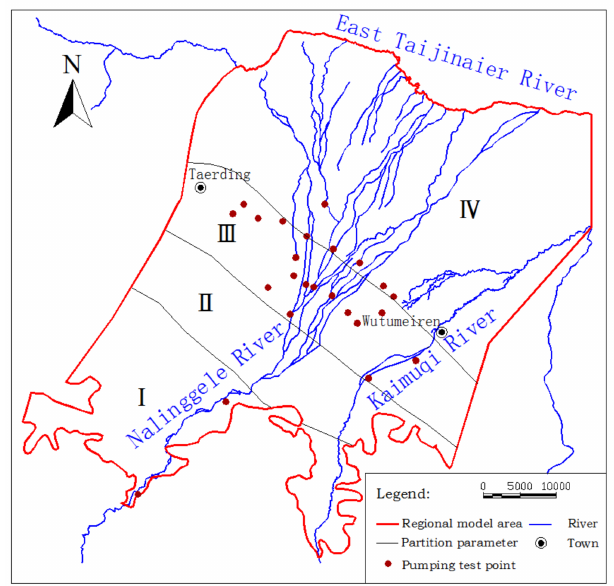
Figure 6. Division of hydrogeological parameters and pumping test